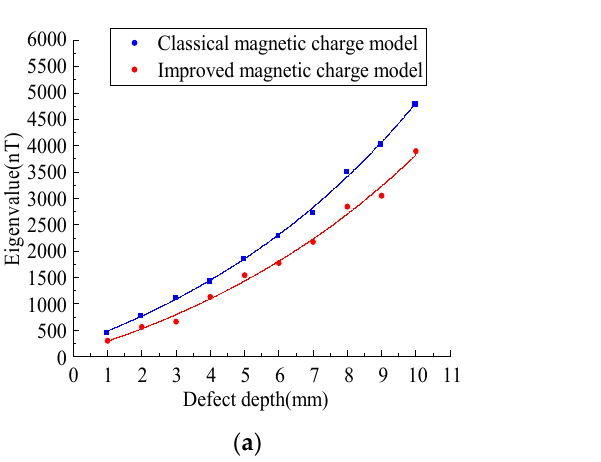
Figure 15. Analysis of characteristic values under different defect depth. ( a ) Analysis of axial eigenvalues under different defect depth. ( b ) Analysis of radial eigenvalues under different defect depth.